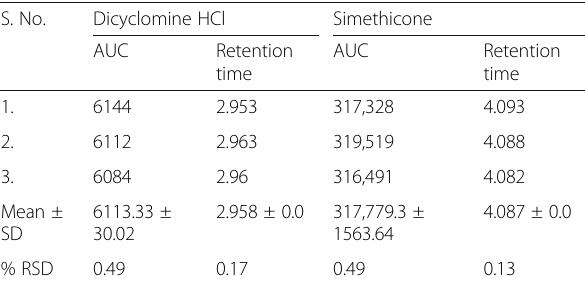
Table 4 System precision study for Dicyclomine HCl and Simethicone standard solutions